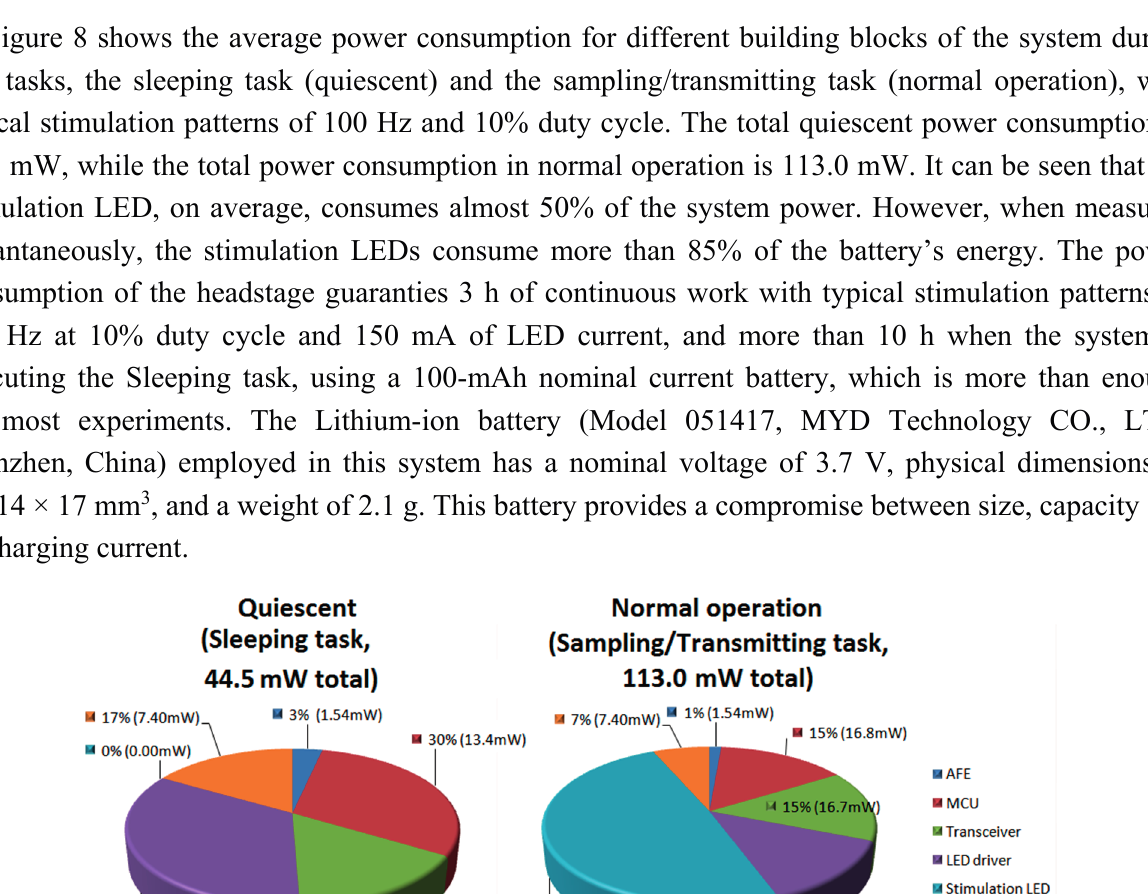
Figure 7. Measured packet losses of the low-power transceiver.